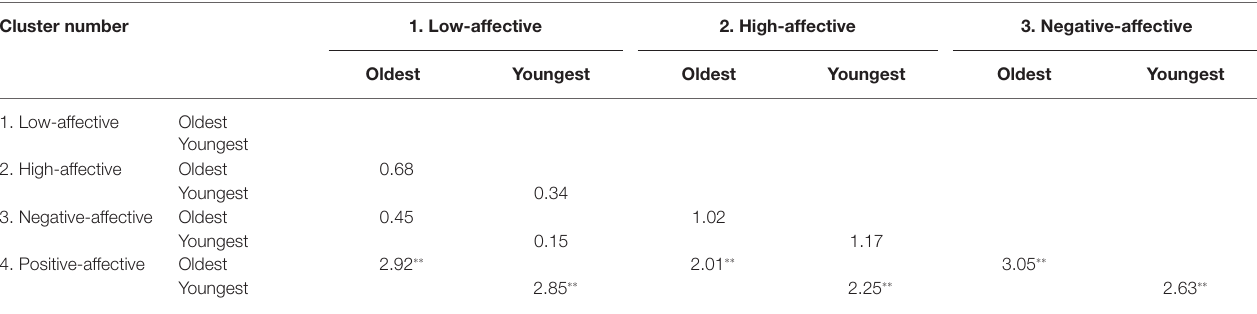
TABLE 1 | Mutual understanding with older and younger children: differences between clusters of parents, t -test absolute values. Cluster number 1. Low-affective 2. High-affective 3. Negative-affective Oldest Youngest Oldest Youngest Oldest Youngest